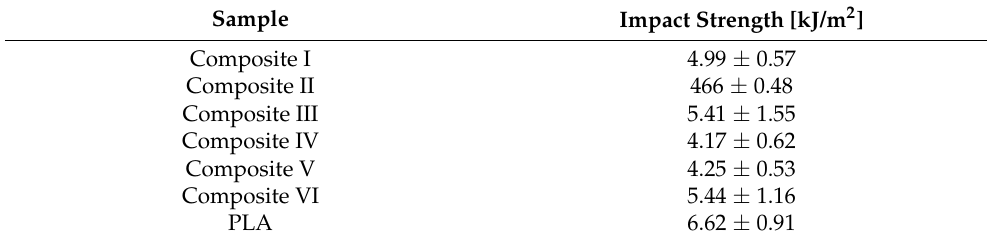
Table 8. Static tensile strength test results.